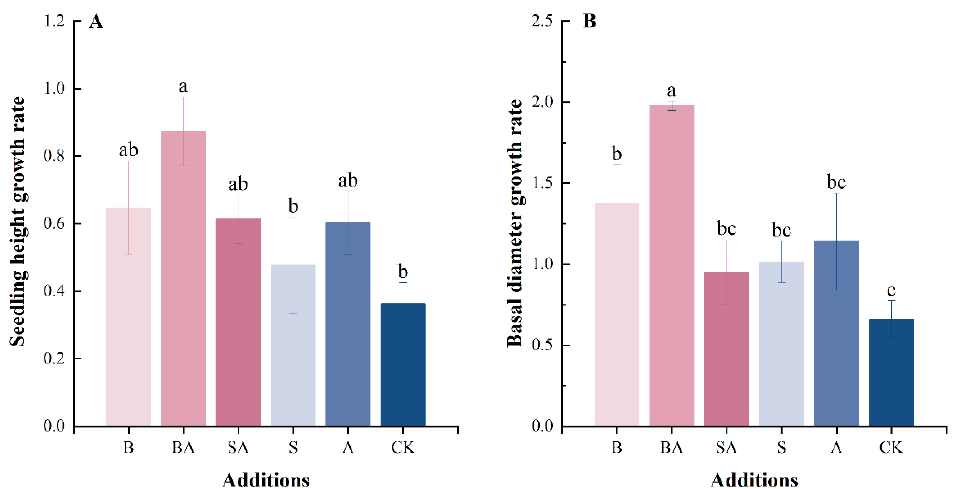
Figure 1. Variations in plant growth rate under different treatments. ( A ) Seedling height growth rate; ( B ) basal diameter growth rate. Different lowercase letters indicate significant differences between various treatments ( p < 0.05). Error bars refer to standard errors.